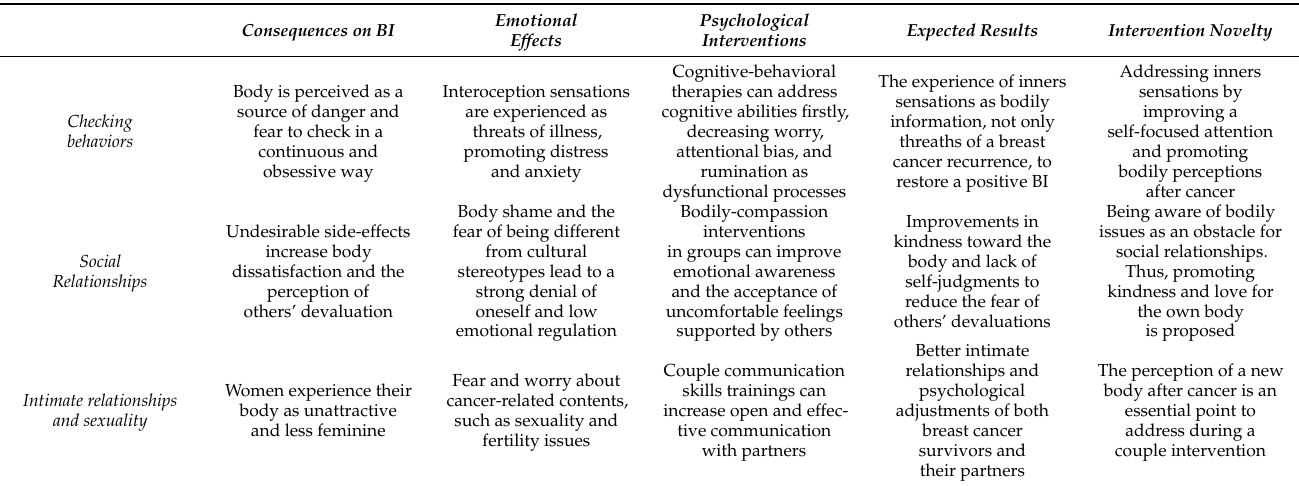
Table 1. BI characteristics, its related emotions, and tailored psychological